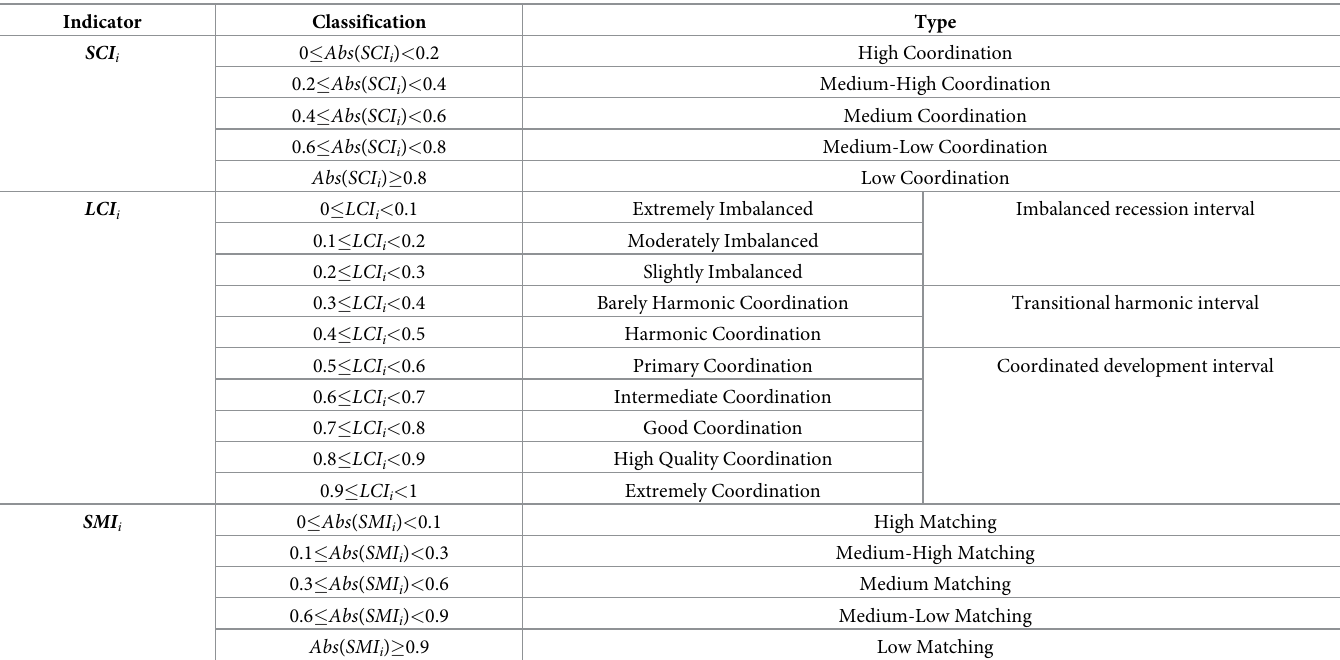
Table 2. Classification of population-land urbanization SCE, LCE and SME indicators.